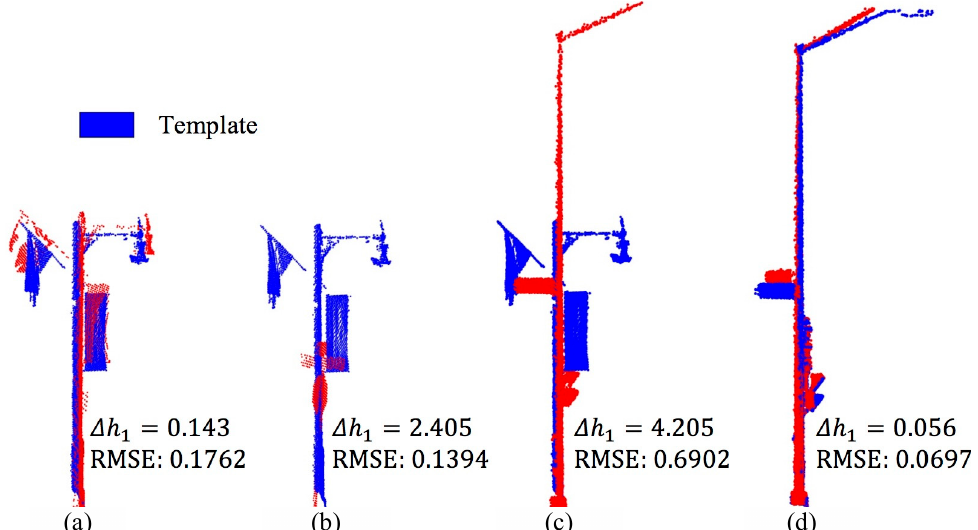
Figure 12. Illustration of the results for 3D shape matching results of poles in Data II (the templates were illustrated in Figure 8). ( a ) and ( b ) are the classified poles of a street lamp and a traffic sign, respectively; ( c ) The pole cannot be classified as a street lamp based on Template II; ( d ) The pole (see ( c )) is classified as a street light after being matched with Template III .